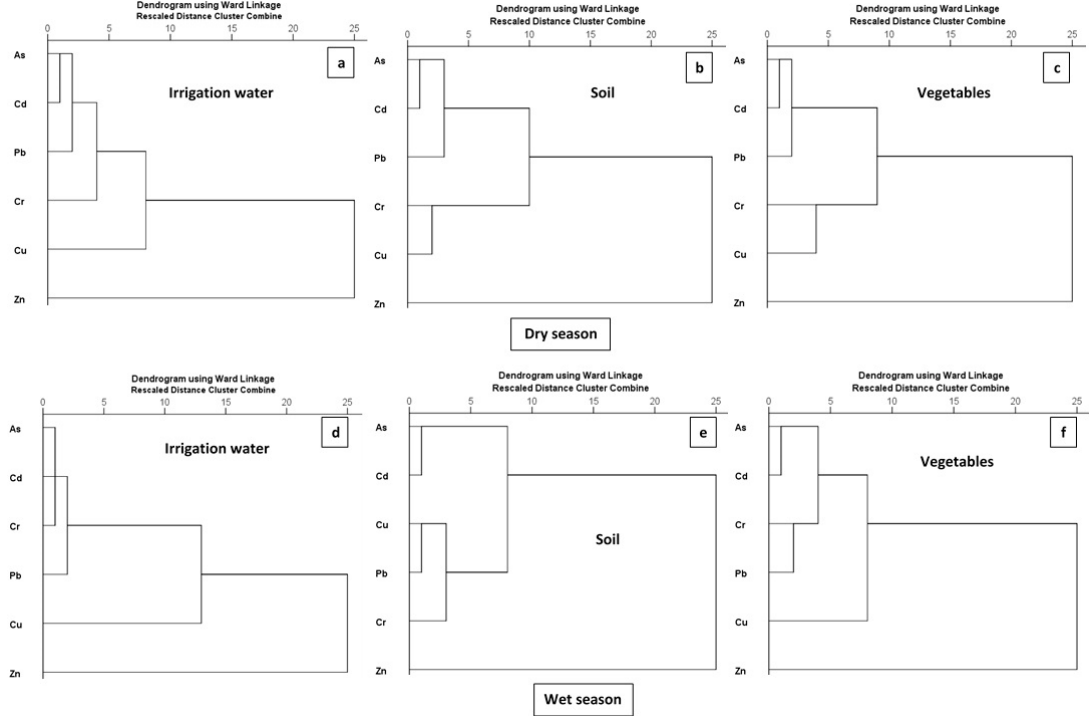
Figure 5. Dendrogram of hierarchical cluster analysis (HCA) of heavy metals in irrigation water, soil, and vegetables.